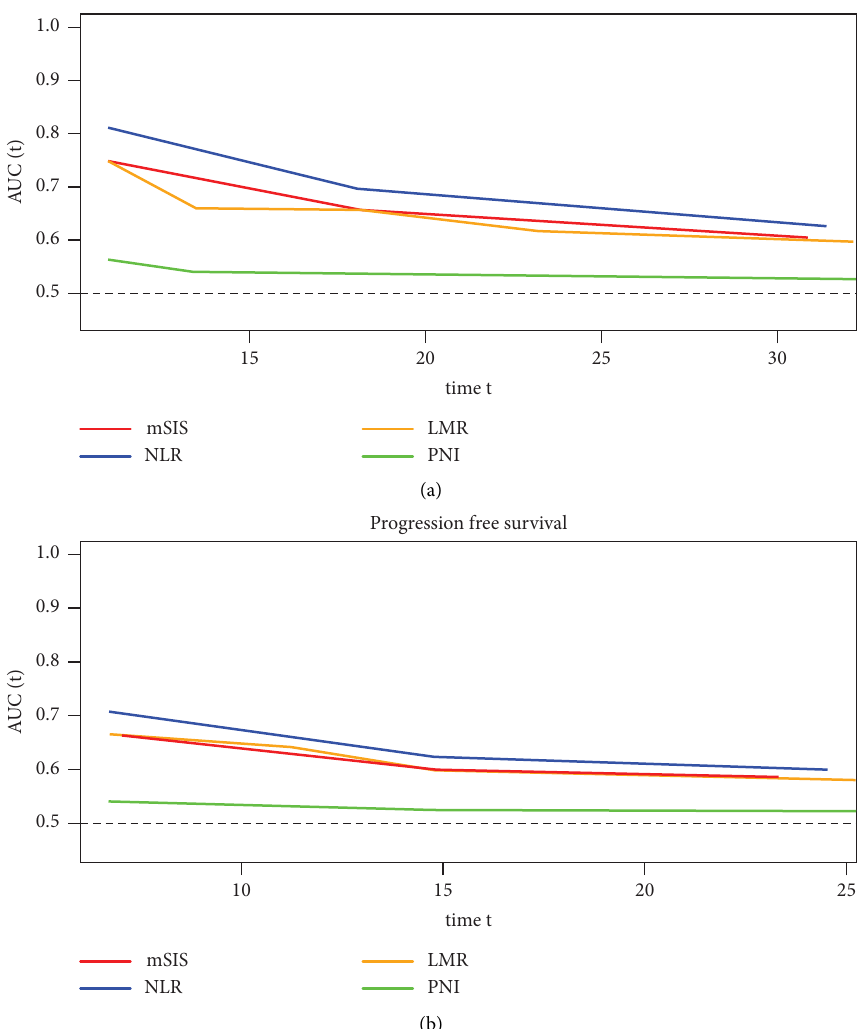
Figure 1: Time-dependent ROC curves for the systemic infammation biomarkers. (a) AUC of each biomarker in over-all survival. (b) AUC of each biomarker in progression free survival. NLR: neutrophil-lymphocyte ratio; LMR: lymphocyte-monocyte ratio; PNI: prognostic nutritional index; mSIS: modifed systemic infammation score. Te x -axis (time) means months after